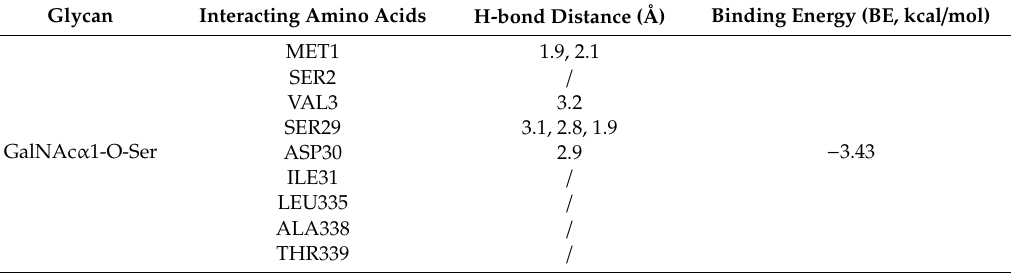
Figure 6. Molecular docking of mucinglycans with GAPDH. ( A ) Three-dimensional model generated by SWISS-MODEL. ( B – D ) Interactions of GalNAc α 1-O-Ser ( B ), GalNAc α Ser ( C ), and Gal β 3GalNAc ( D ) docked to the homology model of Lactobacillus GAPDH. Interacting amino acid residues are labeled, and hydrogen bonds are shown as yellow dotted lines. Table 1. Binding energy in the interaction of L. reuteri GAPDH with different mucin glycans and key amino acid residues.